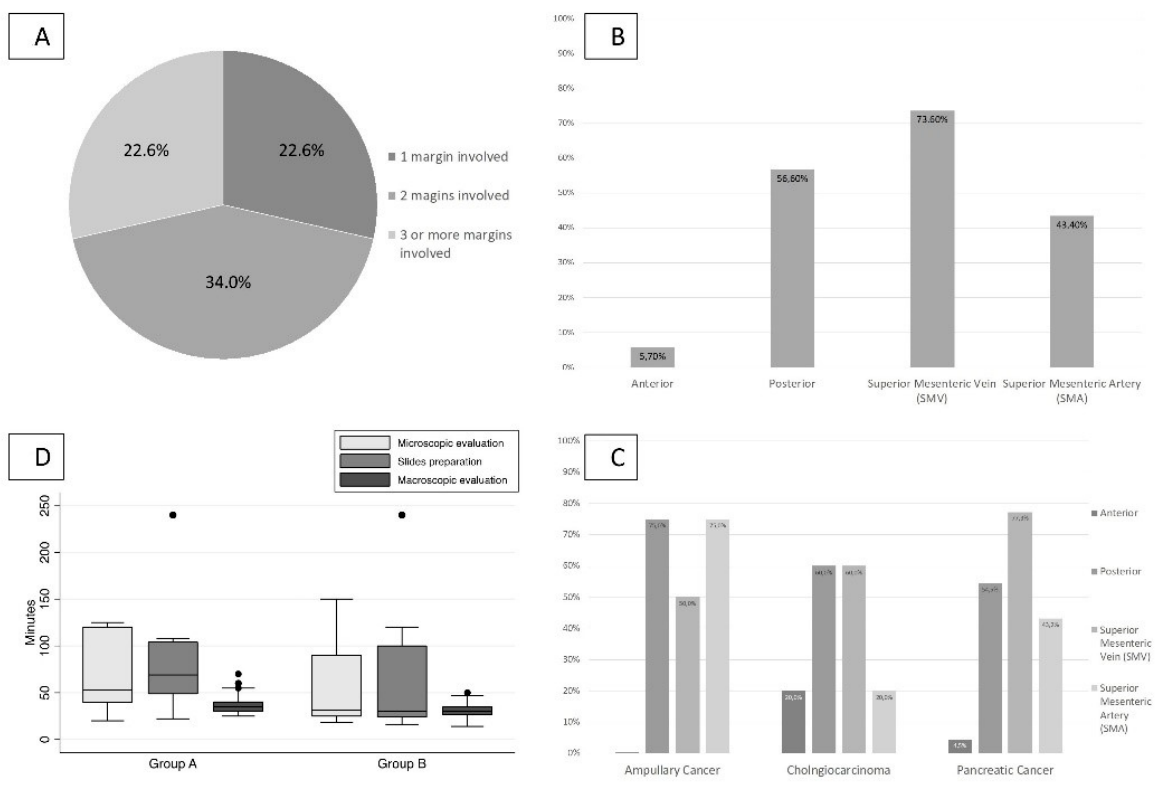
Figure 3. ( A ). Frequency of involved margins in R1 cases. ( B ). Rate of microscopic invasion for each margin in R1 cases. ( C ). Rate of microscopic invasion for each margin in R1 cases for each periampullary tumor. ( D ). Time consumption for the pathological evaluation. Table 3. Association between LR and R1 resection in both study groups, according 0 mm and 1 mm clearance. Group A Group B R0 Resection R1 Resection R0 Resection R1